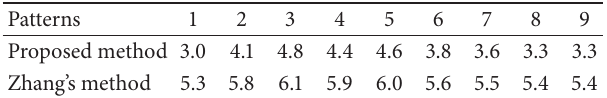
Figure 1: Patterns for the calibration. Table 1: The residuals of the proposed and Zhang’s methods in the central region ( 𝜇